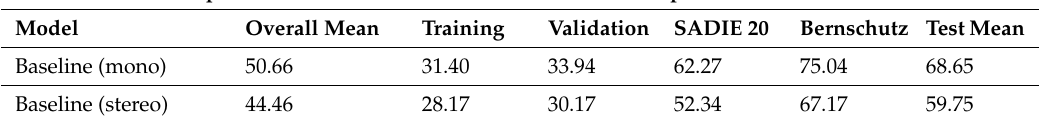
Table 4. Comparison between stereo input and mono input with the baseline model demonstrating that stereo input performs better than mono